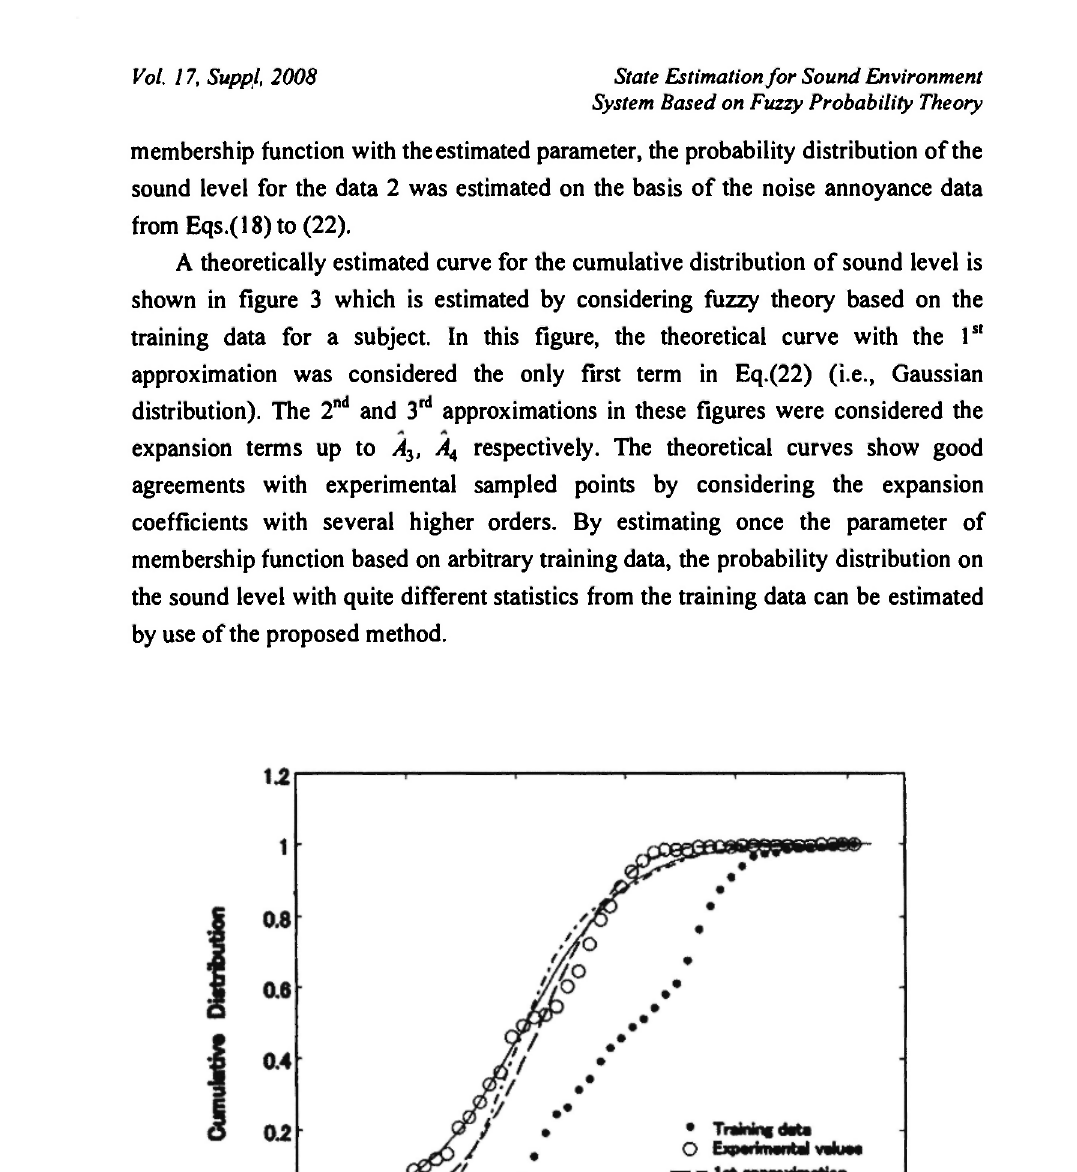
Fig. 3: An estimation result for the cumulative distribution of sound level by considering fuzzy theory based on the training data for a subject